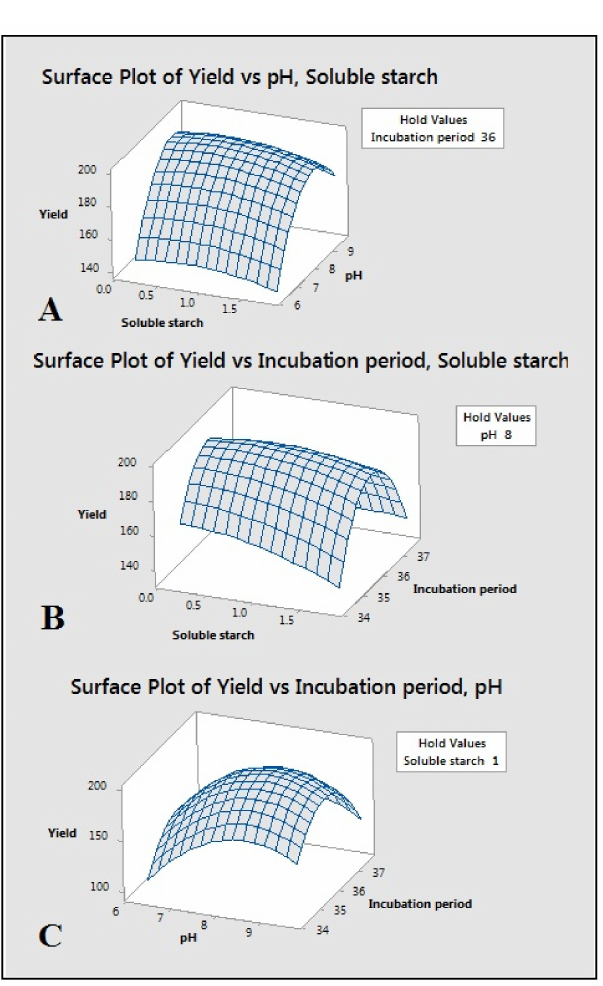
Figure 4. Response surface 3D contour plots representing the interaction between variables affecting amylase production ( A ) soluble starch and pH ( B ) soluble starch and incubation period ( C ) incubation period and pH. While the other variable were kept constant and indicated as hold